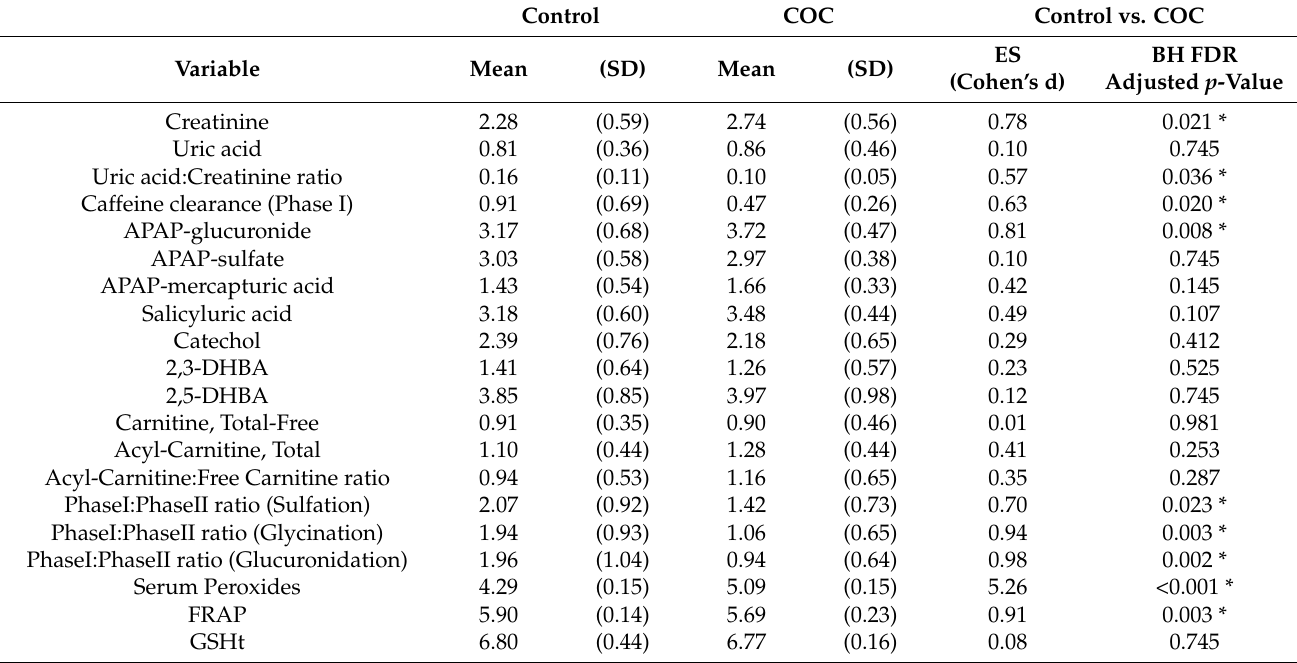
Table 4. Log transformed data of biotransformation efficiency, serum peroxides, and antioxidant capacity. Raw data was log transformed to apply parametric statistical analyses. SD, Standard deviation. ES, effect size. Cohen’s d value: 0.2, small effect; 0.5, medium effect; 0.8, large effect; 1.3, very large effect. * The BH FDR adjusted p -value was considered significant when ≤ 0.1. Untransformed data is available in Supplementary Table S1